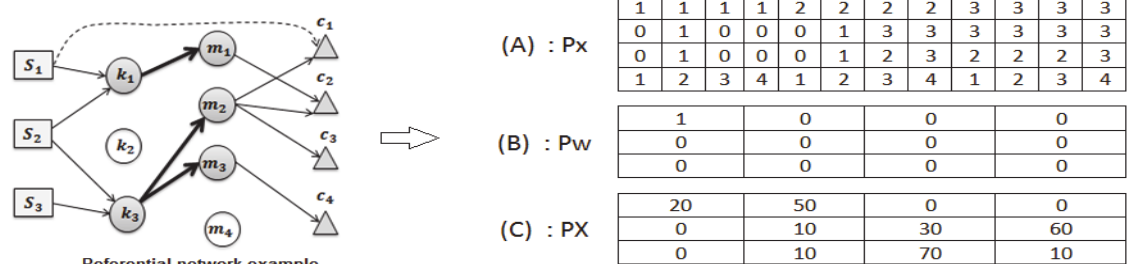
Fig. 3. Proposed representation of